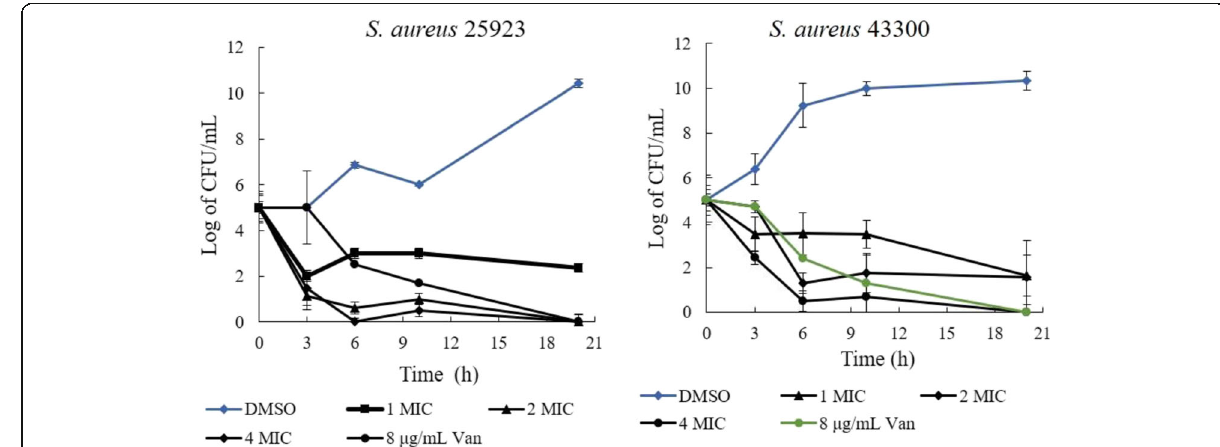
Fig. 2 Time-dependent killing activities of the PGF on strains ATCC 25923 and ATCC 43300. All the CFU values are the average of 6